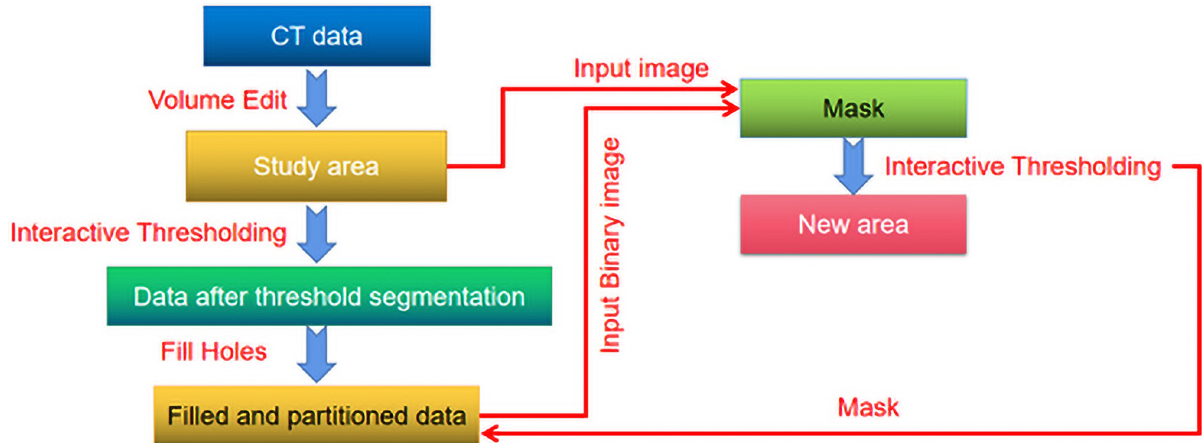
Fig 3. Modular operation flow diagram of pore extraction in carbon fiber composites.